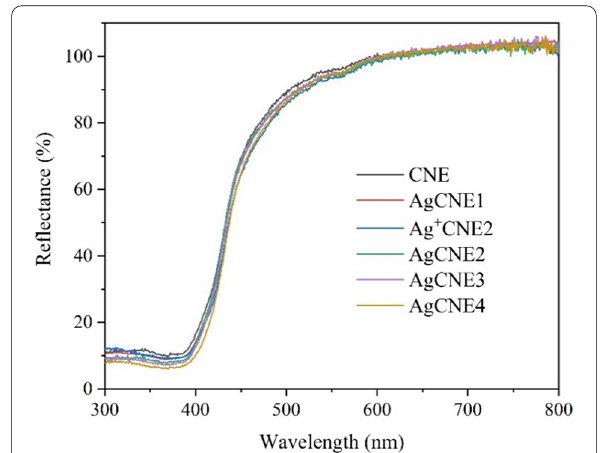
Fig. 11 UV–Vis spectra of AgCNE nanomaterials